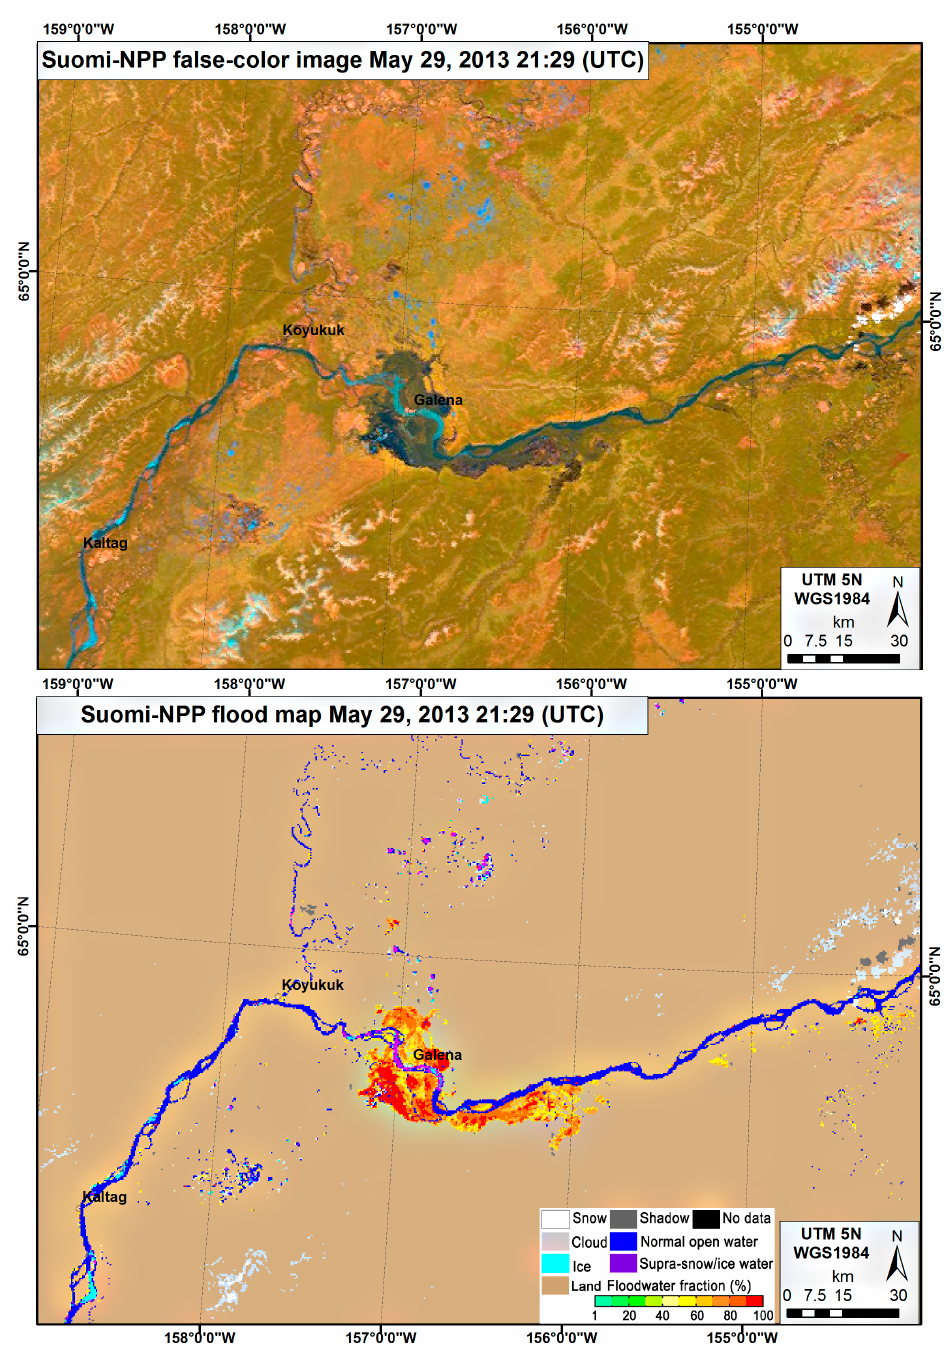
Figure 3. VIIRS false color image ( upper ) and the corresponding flood detection map ( lower ) along the Yukon River near Galena in Alaska on May 29, 2013.